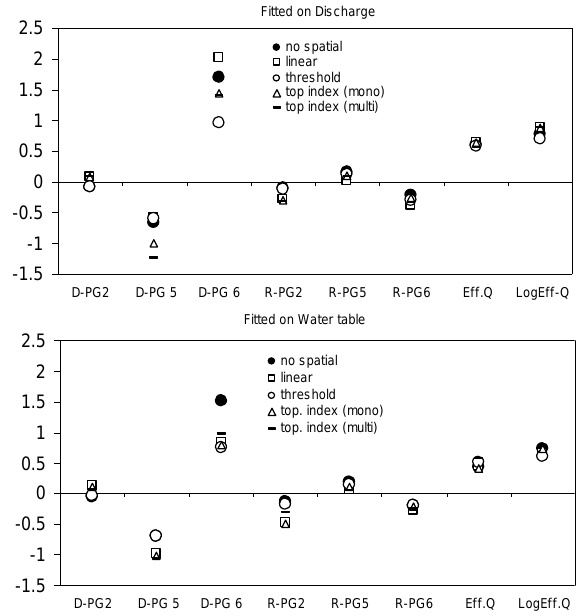
Fig. 7. Mean error ( D ) and log of relative range of variations ( R ) of water table depth, computed for the best simulation fitted to: (a) discharge and (b) water table depth, during the tested period, for three wells – PG2 (bottom), PG5 (midslope) and PG6 (plateau) – for different spatial models of variation in hydraulic conductivity.